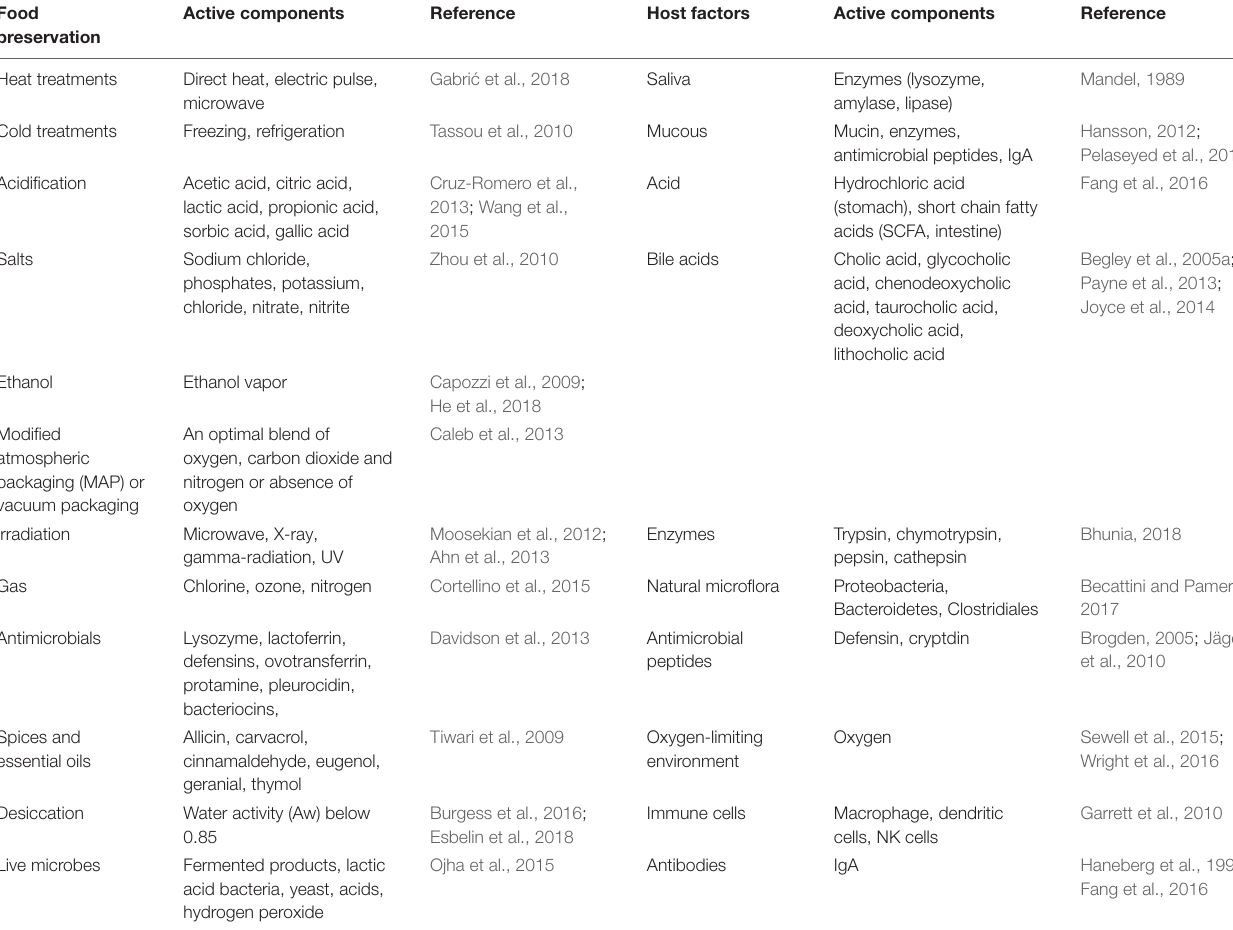
TABLE 1 | Food processing/preservation conditions and host factors that may induce stress in